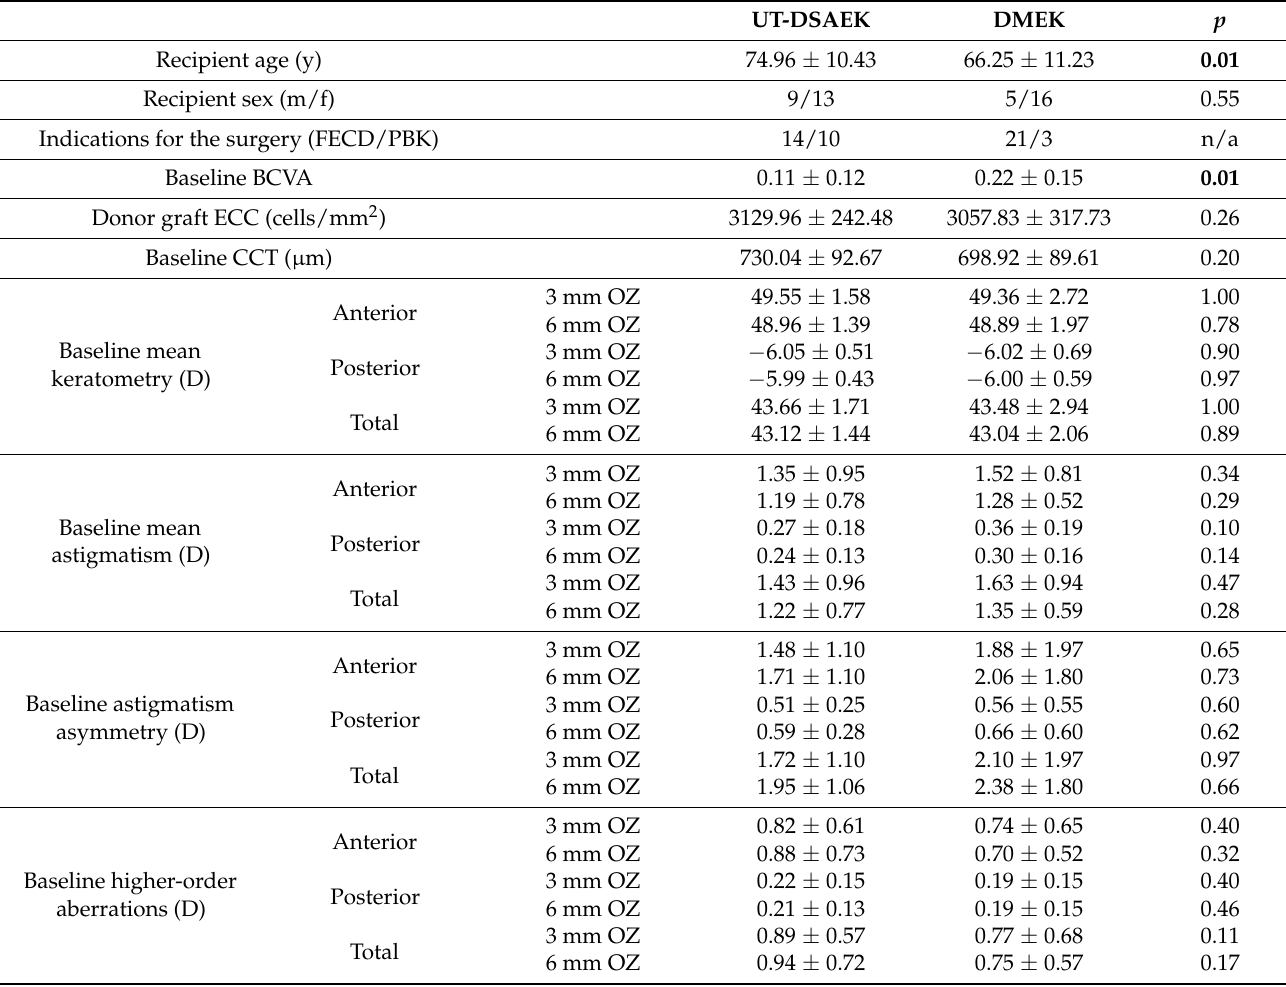
Table 1. Preoperative characteristics of the study groups (mean values ± SD). Statistically significant p -values are shown in